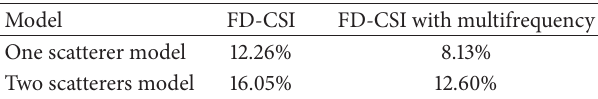
Table 2: Relative errors using FD-CSI and FD-CSI with multiple frequencies